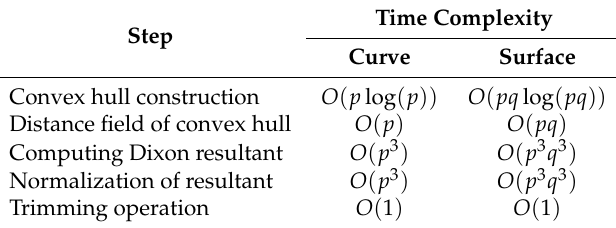
Table 2. Time complexity of each step in Algorithm 1 for computing the algebraic level sets for a Bézier segment. Time complexities are listed for Bézier curves of degree p and Bézier surfaces of degree p × q . Time Complexity Step Curve Surface Convex hull